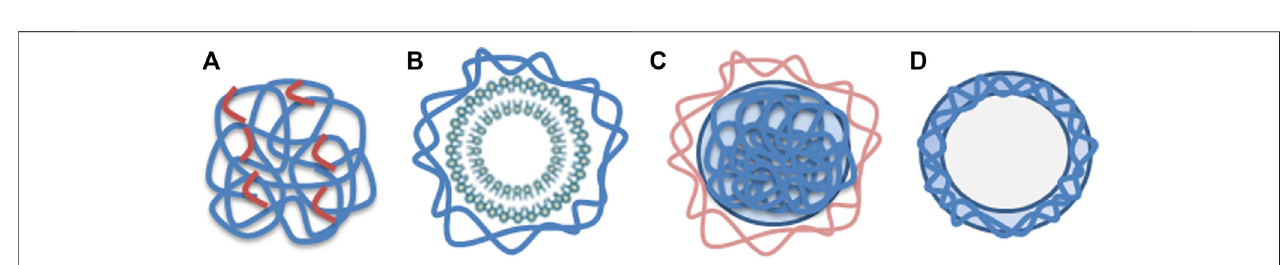
FIGURE2|(A) Nanospherecomposedofchitosan(blue)withcrosslinkers(red), (B) Liposome(green)withchitosancoating(blue), (C) Chitosannanoparticle(blue) covered with other substance (light brown) such as proteins or polymers, (D) Nanocapsule made of chitosan (blue).